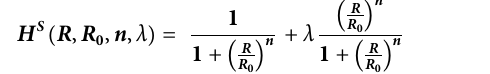
FIGURE 2 | Same as (B , C) for intermediate Nrf2 activation ( g NRF 2 (cid:1) 0 . 5 × 10 5 molecules/hour). (F , G) Same as (B , C) for strong Nrf2 activation ( g NRF 2 (cid:1) 10 5 molecules/ hour). (H) CrossoverpointwherethefractionofhybridE/M cellsbecomeslargerthanthefractionofMcellsasafunctionofNrf2production rate. (I) ComparisonofZEB1 levelsbetweensimulation(redline)andcontrolexperiment(blackline)inthe fi rst13celllayers. (J) Fold-changeinZEB1levelsbetweenthe fi rstandsecondcelllayersasa function of Nrf2 production rate. Result for panels C-E-G-H-I-J are averaged over fi ve independent